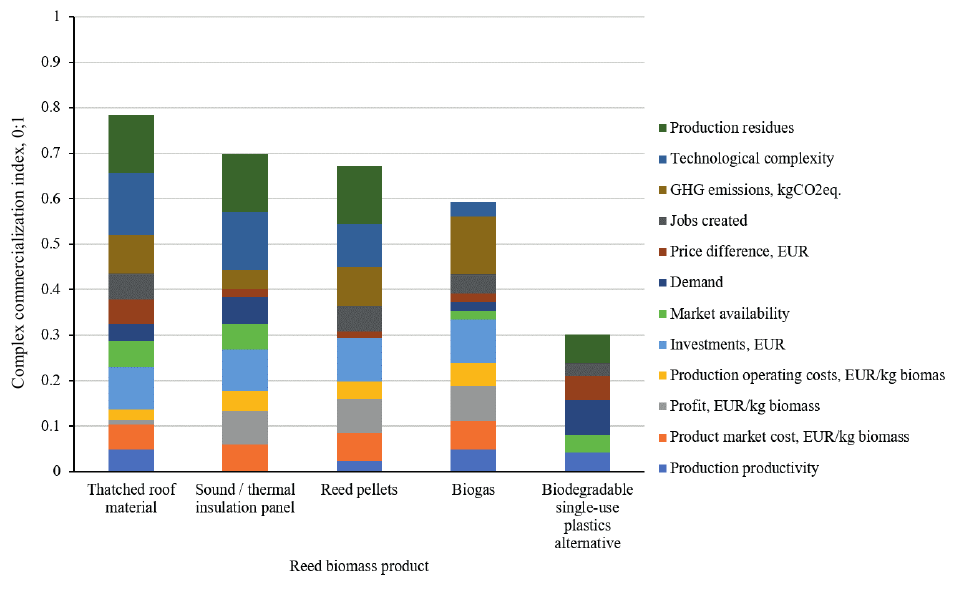
Fig. 6. Complex commercialization index values for potential reed biomass